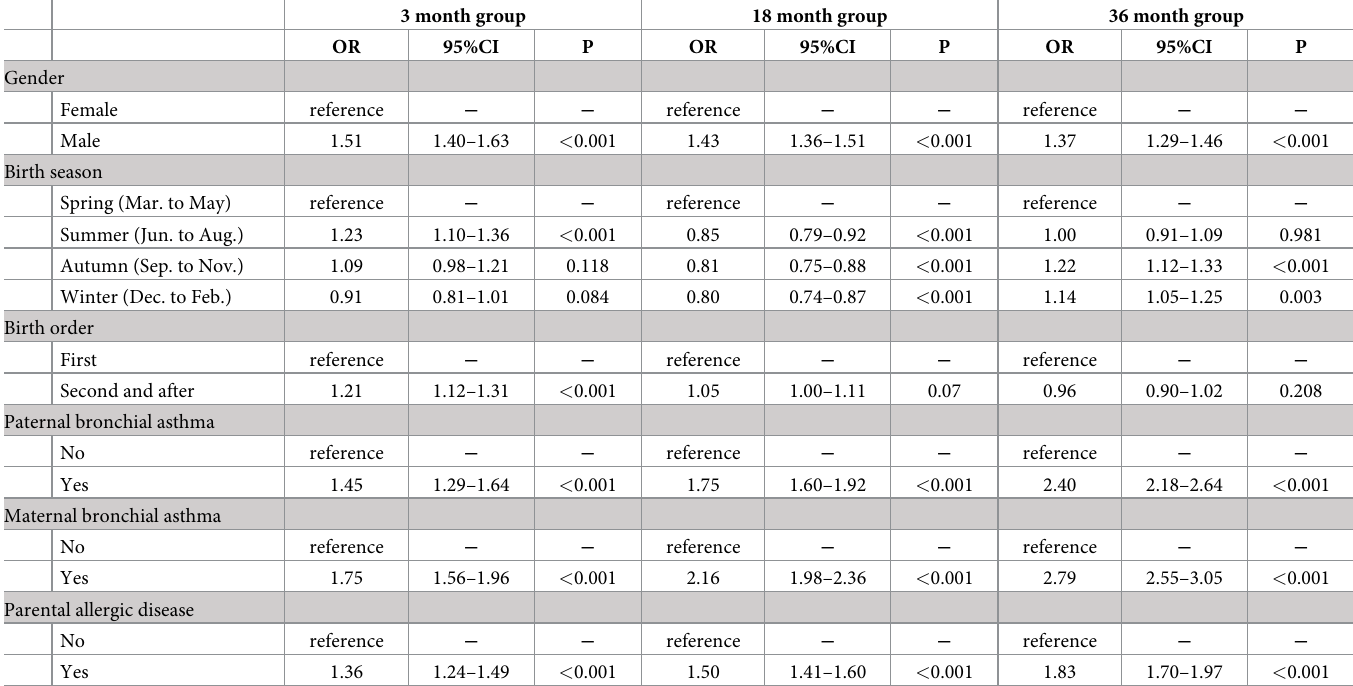
Table 2. Univariate analysis between wheeze and covariates in three age